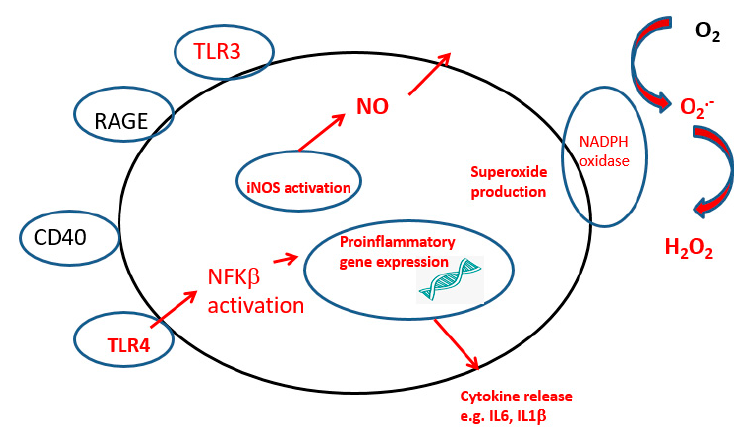
Figure 4. Activated microglia showing receptors involved in the instigation of the inflammatory process. DAMP, Damage-associated molecular pattern molecules TLR. Toll-like receptors; NADPH, nicotinamide adenine dinucleotide phosphate oxidase; RAGE, receptor of advanced glycation end-products; CD, cluster of differentiation. The major inflammatory pathway is marked in red.